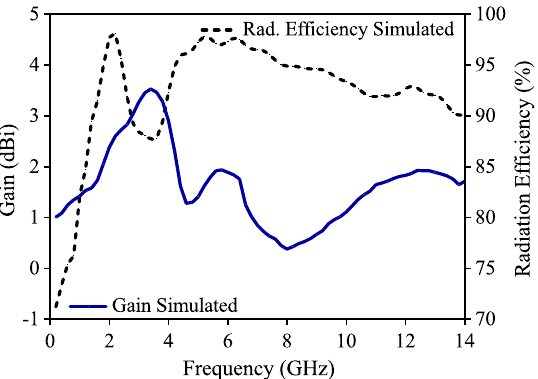
FIGURE 10: Simulated gain and radiation efficiency of pro- posed single element.